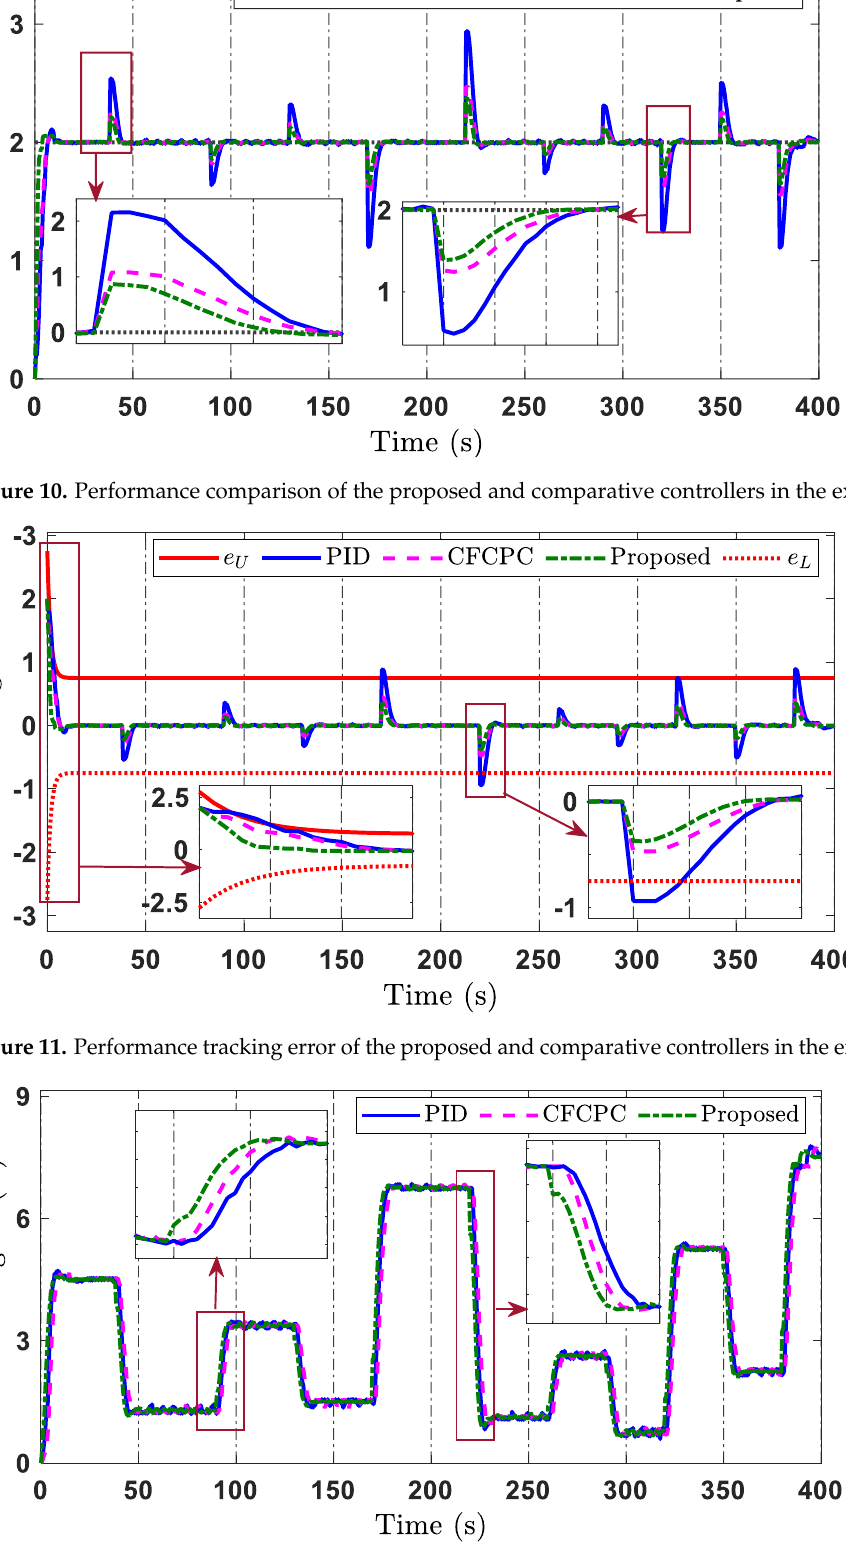
Table 3. Performance indexes of three controllers in experiment. Controller